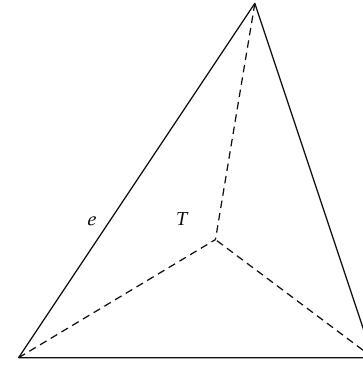
Figure 1: Element T ∈ T h for triangular mesh.